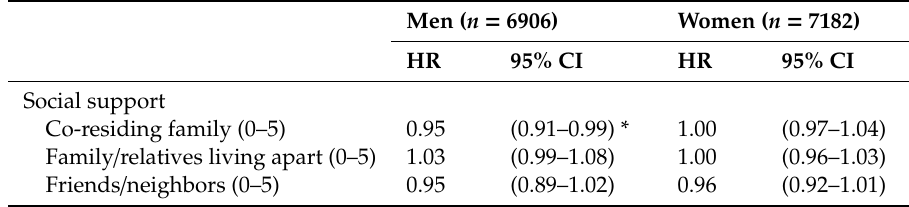
Table 3. Social support and incident dementia by Cox proportional hazard